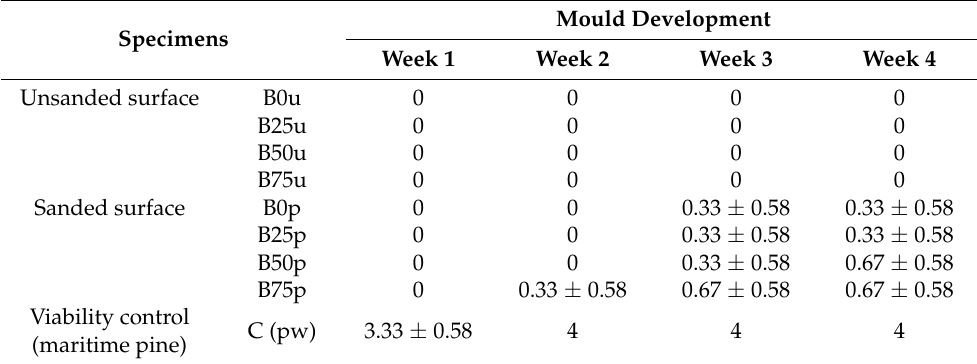
Table 4. Average rate ( ± standard deviation) of mould growth (n = 3).